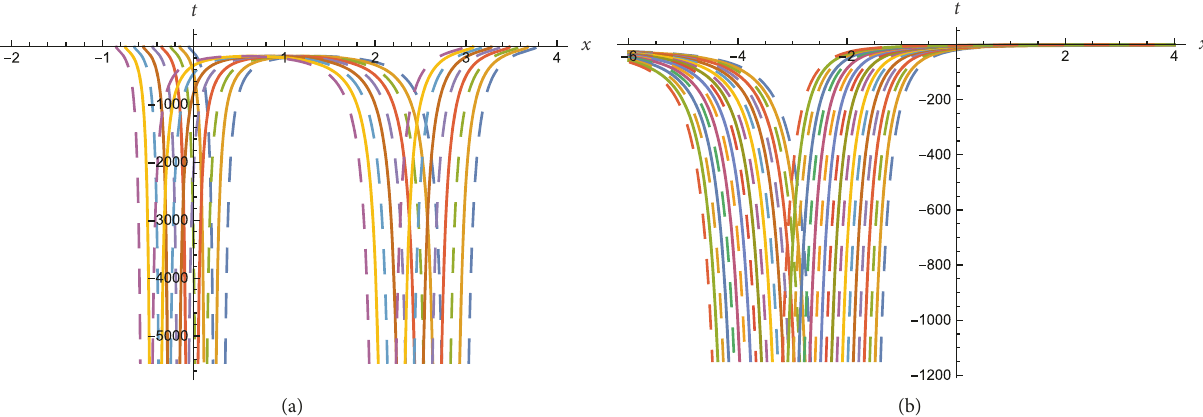
= 1;𝑙 = 5; 𝑙 = 5;𝑙 = 0; 𝜅 = 0.7;𝑐 = 0.1;𝑦 = 0.8 1 2 3 4